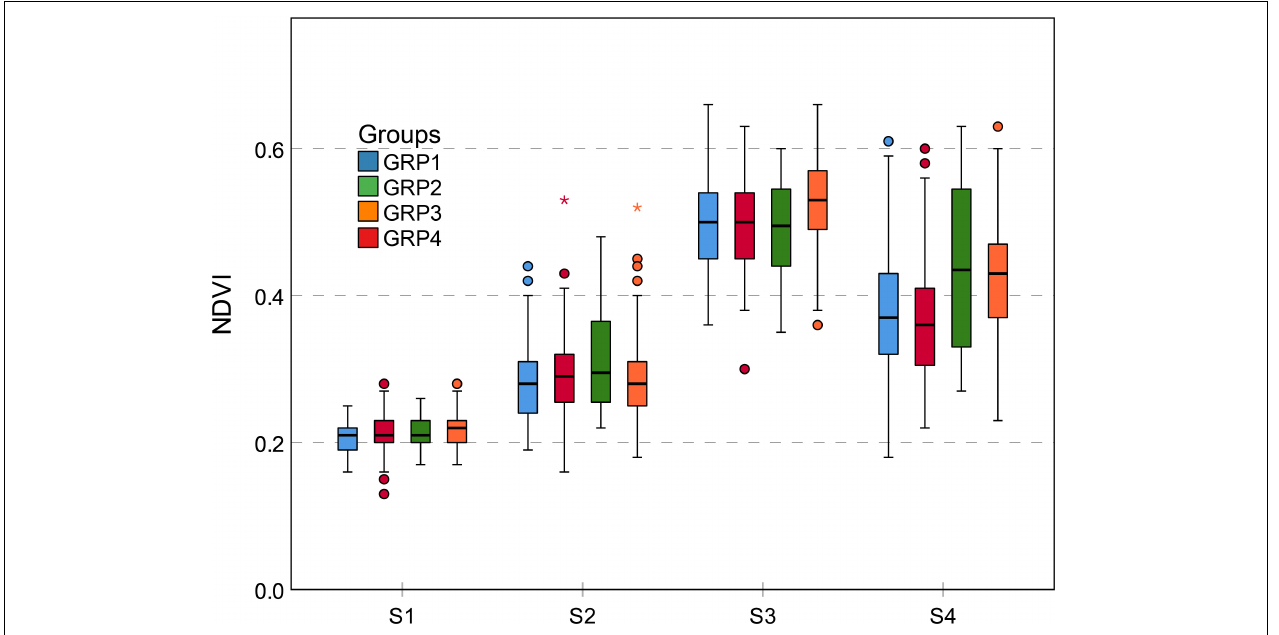
FIGURE 11 | Grouped boxplot for genetic background of NDVI trait. Outliers are shown as dots and asterisks. The difference of NDVI between four groups is most obvious at the S4 growth stage. All groups achieved the largest NDVI at S3 growth stages. GRP2 and GRP3 have less NDVI decline at the S4 growth stage. NDVI, normalized difference vegetation